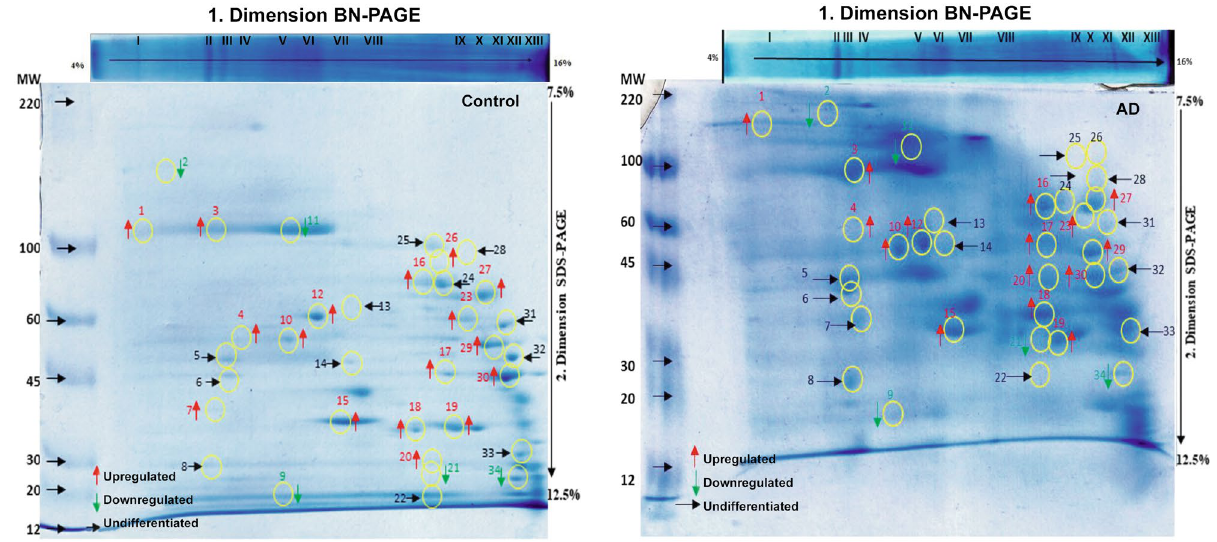
Figure 2. BN/SDS-PAGE map acquired from separation of ageing control and AD protein complexes isolated from human brain prefrontal cortex. Representative spots separated on 12.5–7.5% SDS-PAGE in second dimension and Coomassie stained. The identified spots with increased expression are marked in red, whereas lower expressed spots are marked in green. Undifferentiated protein spots are marked in